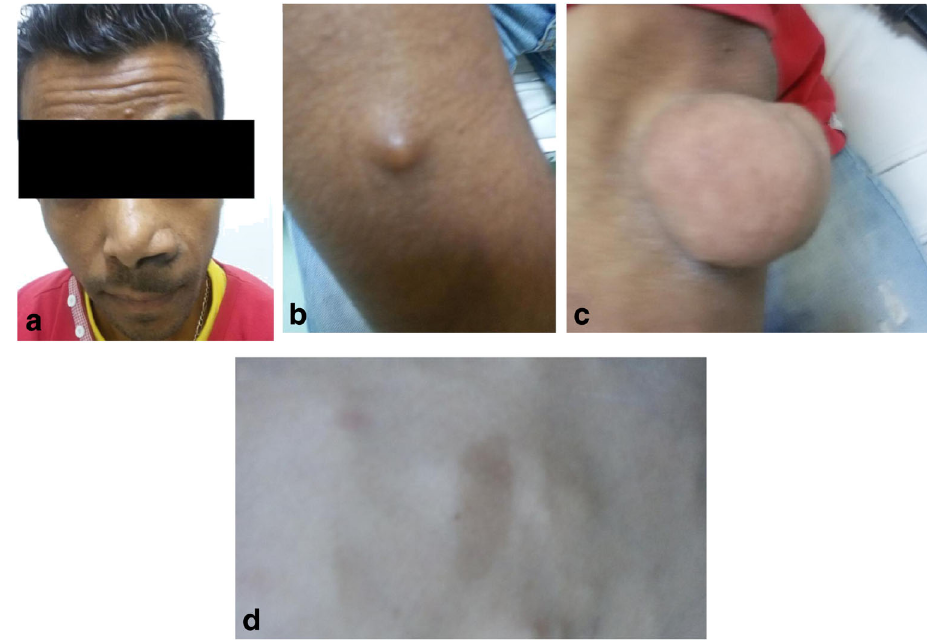
Fig. 1 Different cutaneous manifestations of NF1 including: ( a ) plexiform neurofibroma in the face; ( b , c ) neurofibromas; ( d ) B café au lait ^